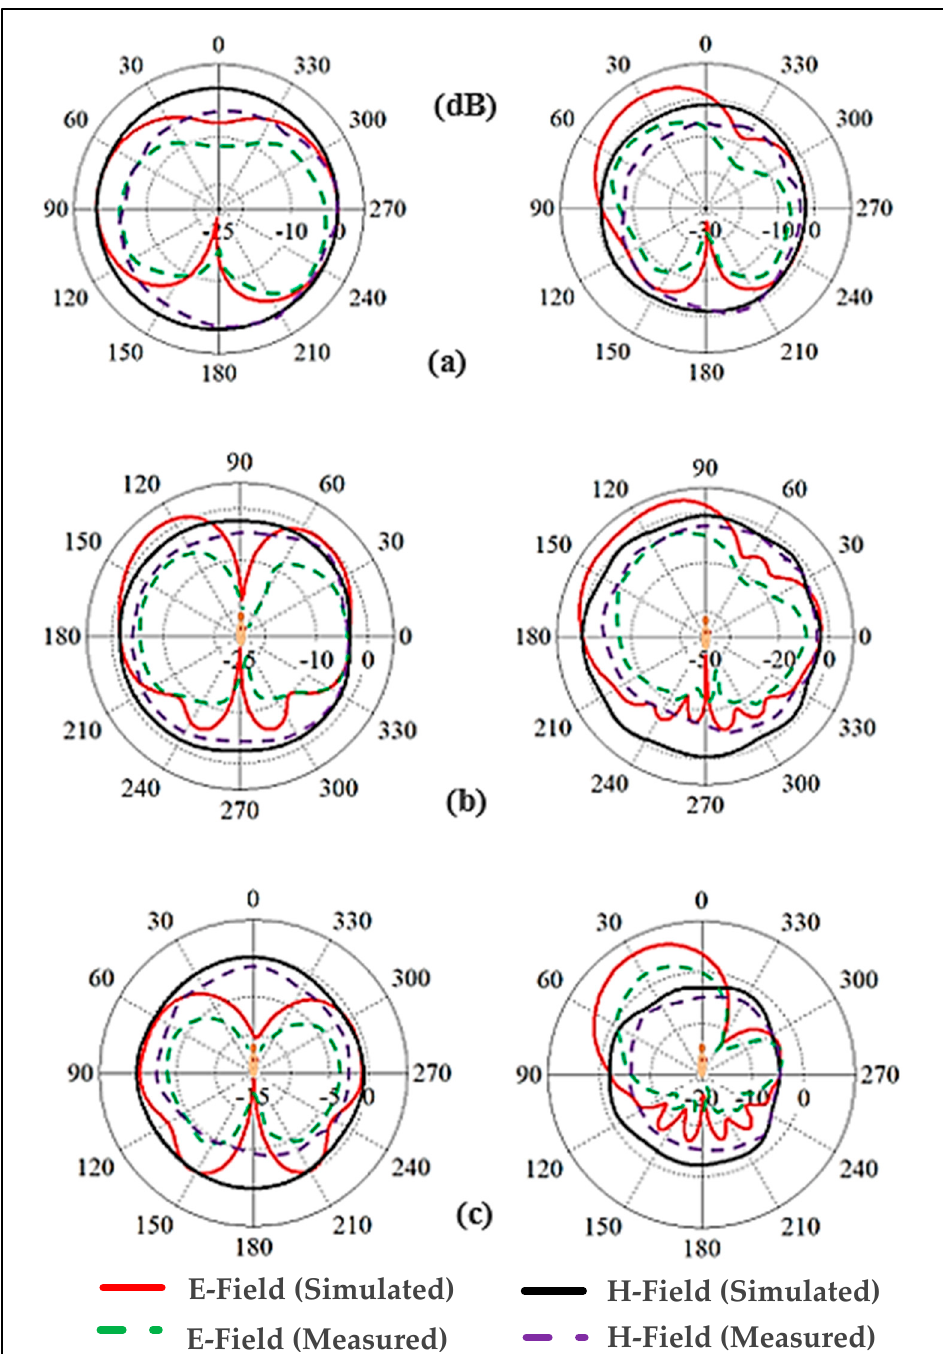
Figure 23. ( a ) Setup for far-field measurement, ( b ) phantom for the chest position, and ( c ) phantom for the arm position.